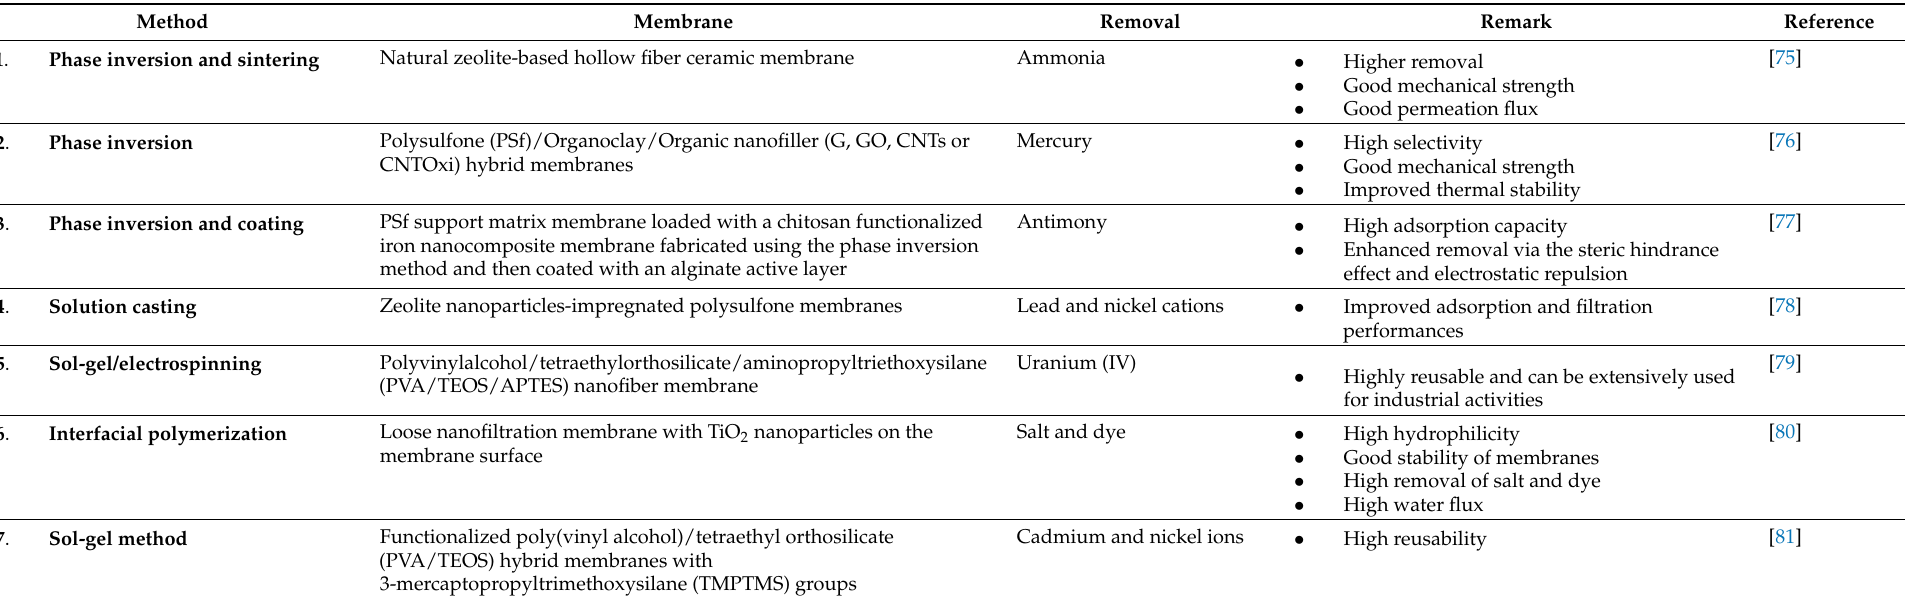
Table 3. Preparation of hybrid adsorptive membranes based on previous